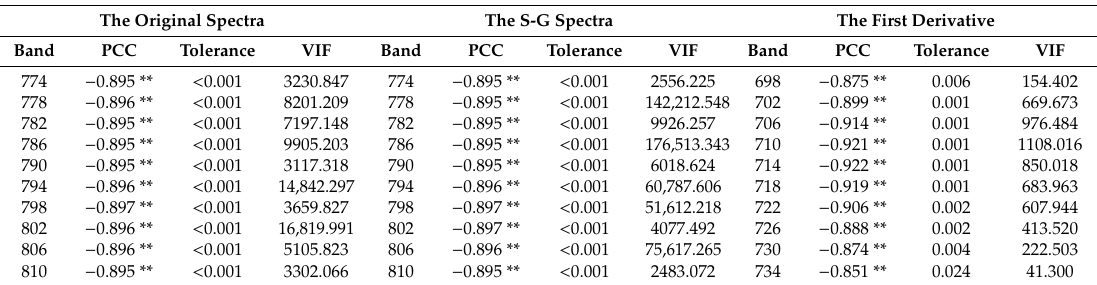
Table 6. The results of the correlation analysis and collinearity diagnosis of di ff erent spectral processing methods. The Pearson correlation coe ffi cient (PCC) is the result of the Pearson correlation analysis; Tolerance and Variance Inflation Factors (VIF) are the results of the collinearity diagnosis.